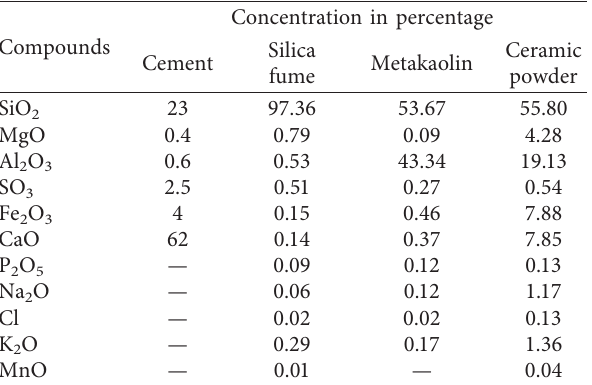
Table 1: Compounds of cement and other mineral admixtures obtained from